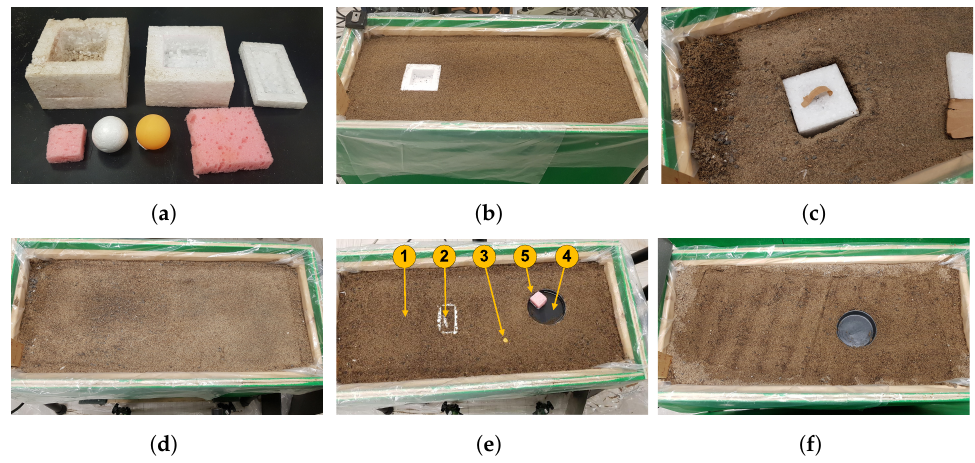
Figure 4. Cavity configurations used in tests. ( a ) Objects used to create cavities. ( b ) Cavity configu- ration 1. ( c ) Cavity configuration 2 (within the process). ( d ) Cavity configuration 2 (cannot be seen since it is covered by soil). ( e ) Cavity configuration 3 (combined 5 different cavities in one setup). ( f ) Cavity configuration 4.